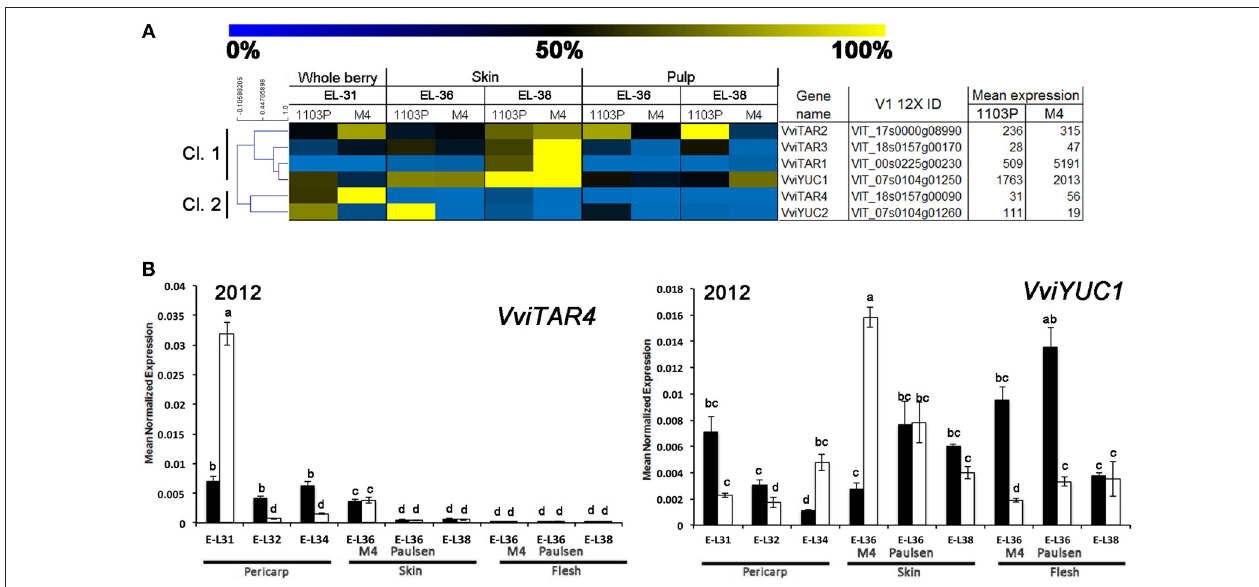
FIGURE 6 | (A) Heat-map showing the expression of auxin-biosynthetic genes based mRNA-Seq data. The expression values were calculated as a percentage related to the developmental stage showing the highest expression value (100 and 0% for yellow and blue colors, respectively) within all mRNA-seq datasets considered (E-L31, E-L36, and E-L38). Proposed gene name ( Supplementary Results S1 ), PN40024V1 12X identifier, and mean of normalized counts are also reported. (B) Quantitative RT-PCR analyses on VviTAR4 and VviYUC1 in flesh and skin of berries sampled from both 1103P/CS (solid bars) and M4/CS (empty bars) graft combination in 2012 growing season. Results are shown as means and SE for three biological replicates. Bars indicate SE. Different letters indicate statistically significant differences ( P = 0.05 ) by Duncan’s new multiple range